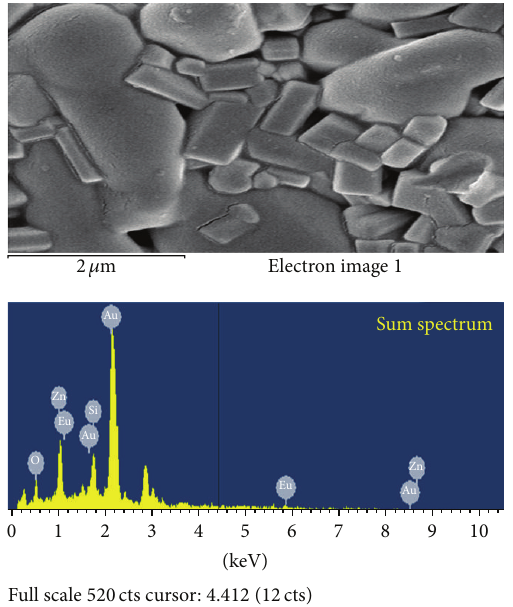
Figure 9: Microstructures of 3 wt% Eu 2 O 3 doped willemite samples sintered at 1000 ∘ C for 4 h where the EDX analysis was